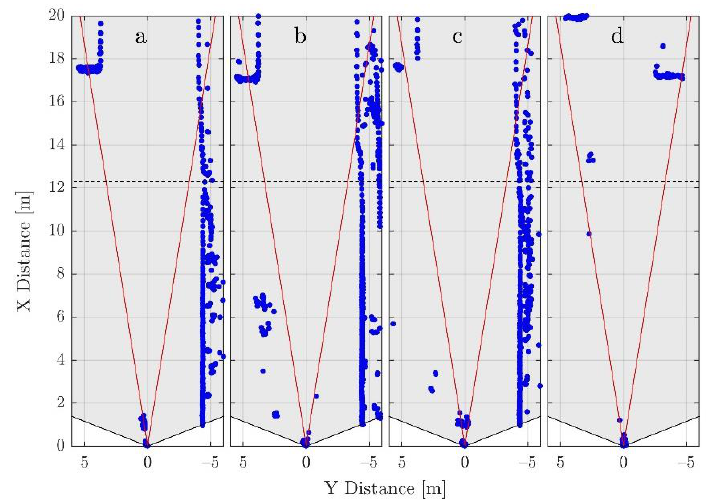
Figure A1. Examples of the point clouds generated by different road boundaries ( a – c ) and vehicles in other lanes ( d ). The ROI is limited in ‘y’ by the read lines and in ‘x’ by the dotted line.